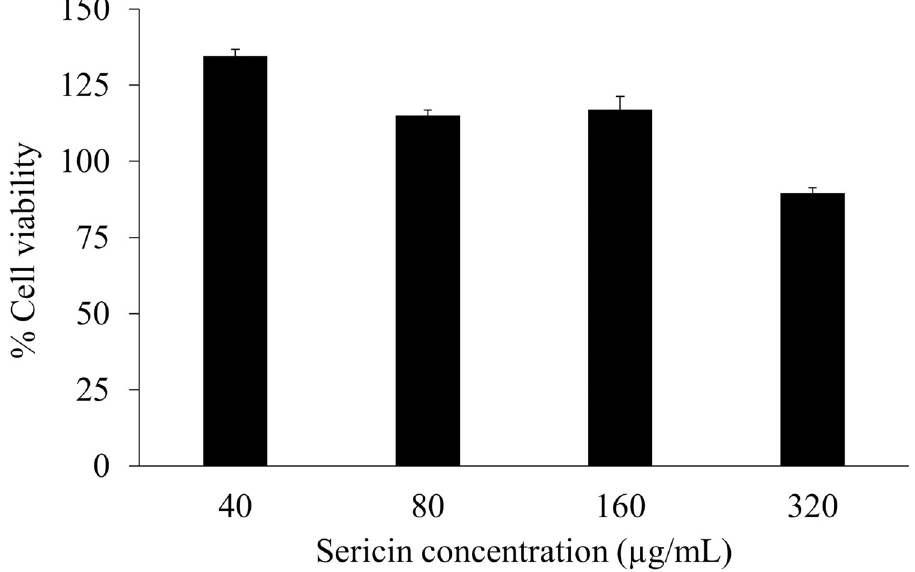
Fig 5. The effect of sericin extract on the viability of MC3T3-E1